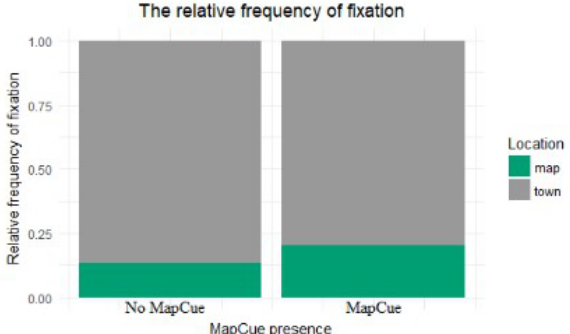
Figure 5. The relative frequency of fixations: the right column represents fixations when a salient landmark on the map